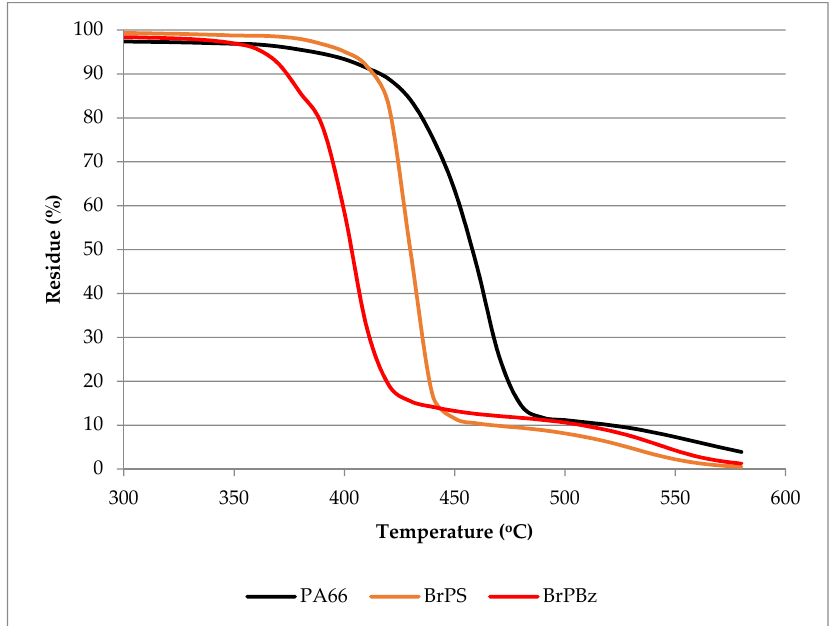
Figure 2. TGA mass losses of PA66 and PA66 samples containing 10 wt.% brominated polystyrene, BrPS, and and poly(pentabromobenzyl acrylate), BrPBz, under air. Table 1. Thermogravimetric and differential thermogravimetric (TGA/DTG) results for PA66/tungstate/PolyBrFR formulations in air.